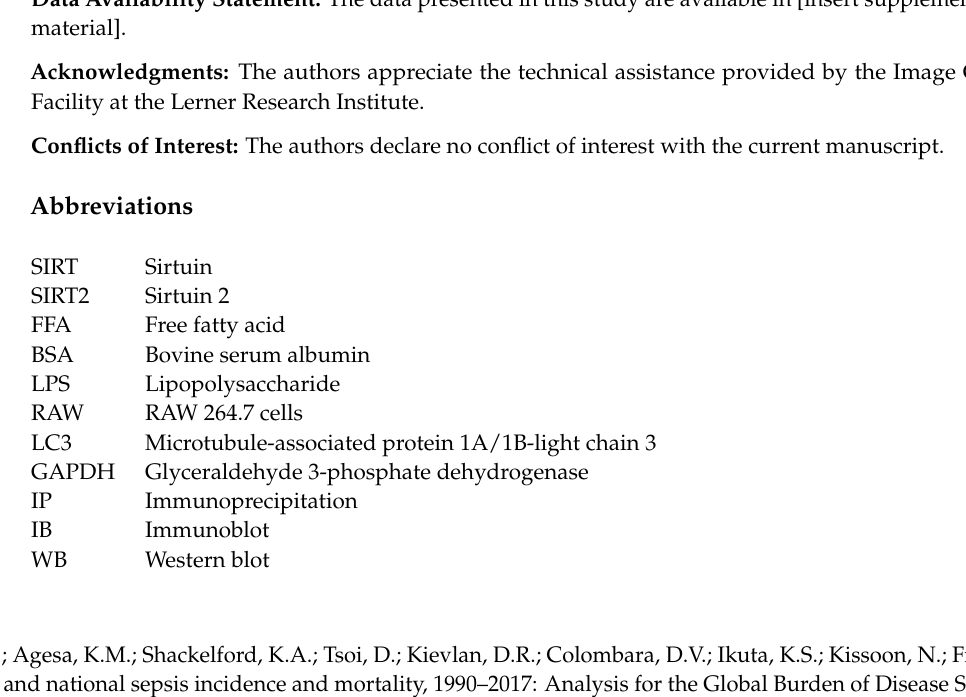
Figure S2: Colocalization of SIRT2 and p62 in sensitive and tolerant macrophages; Figure S3: Total alpha-tubulin expression in sensitive and tolerant macrophages; Figure S4: Colocalization of SIRT2 and p62 in sensitive and tolerant